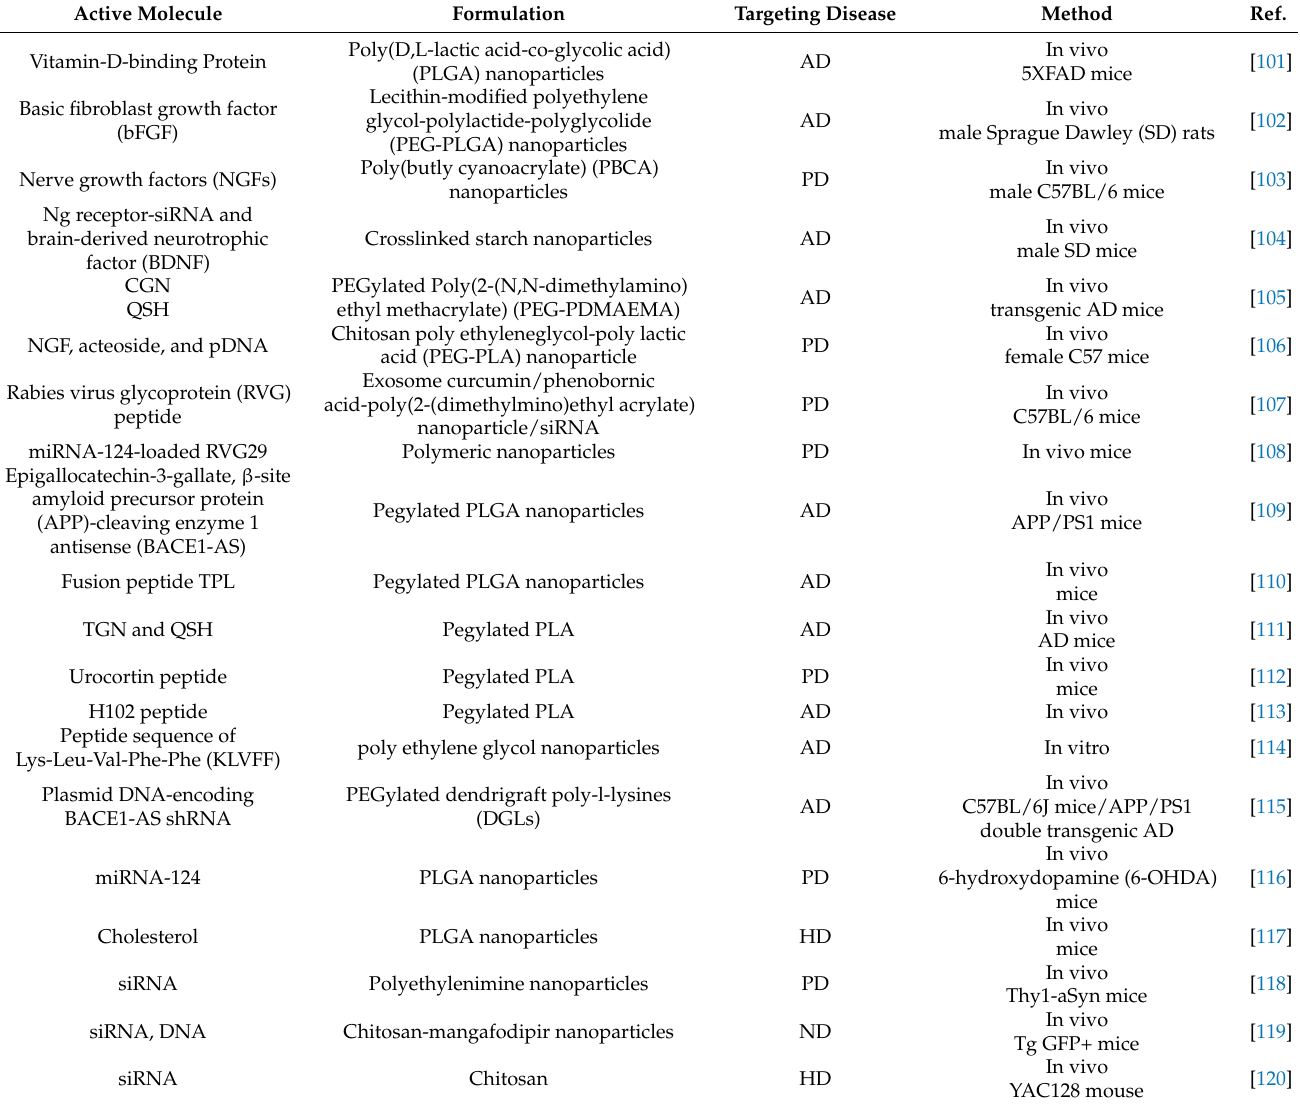
Table 1. Pharmaceutical formulations with proteins and genes targeting neurodegenerative disorders using polymeric